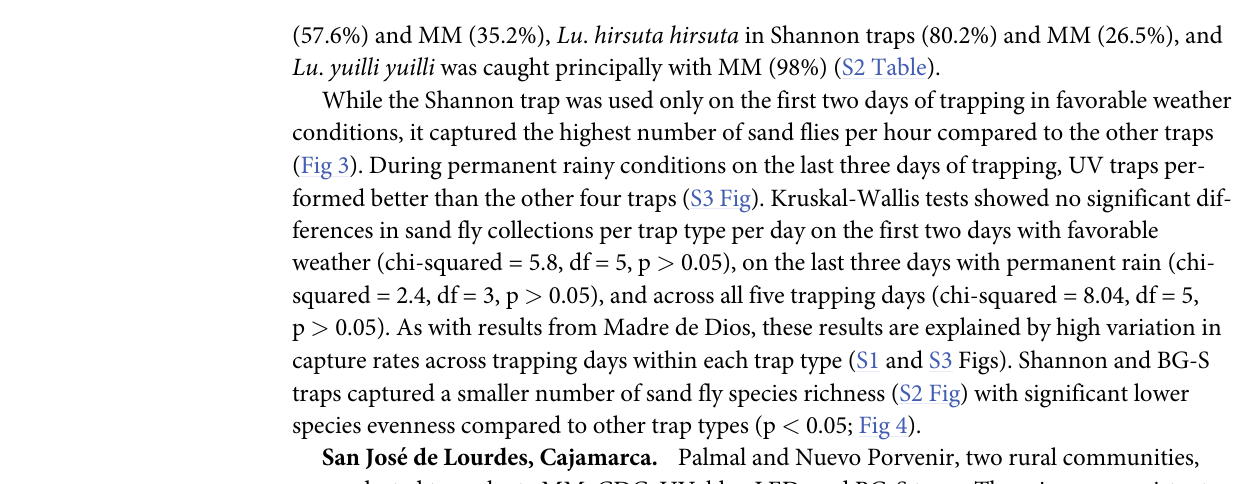
Fig 3. Comparison of cumulative sand flies per hour collected from 1800 to 0600 for a two-day period across trap types and study sites.